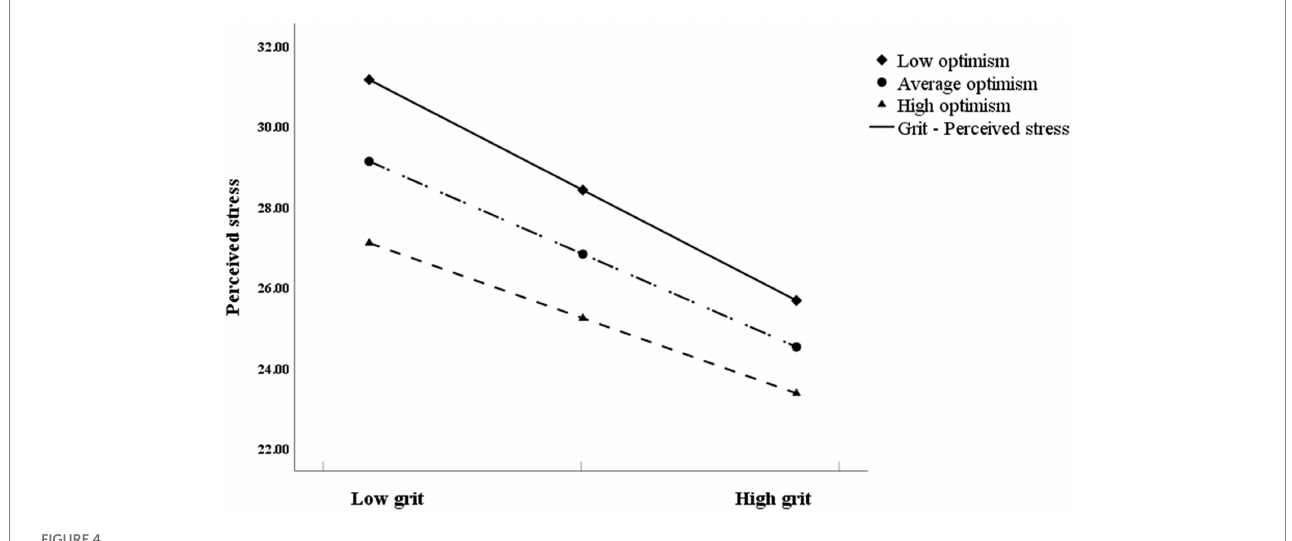
FIGURE 4 The moderation plot for